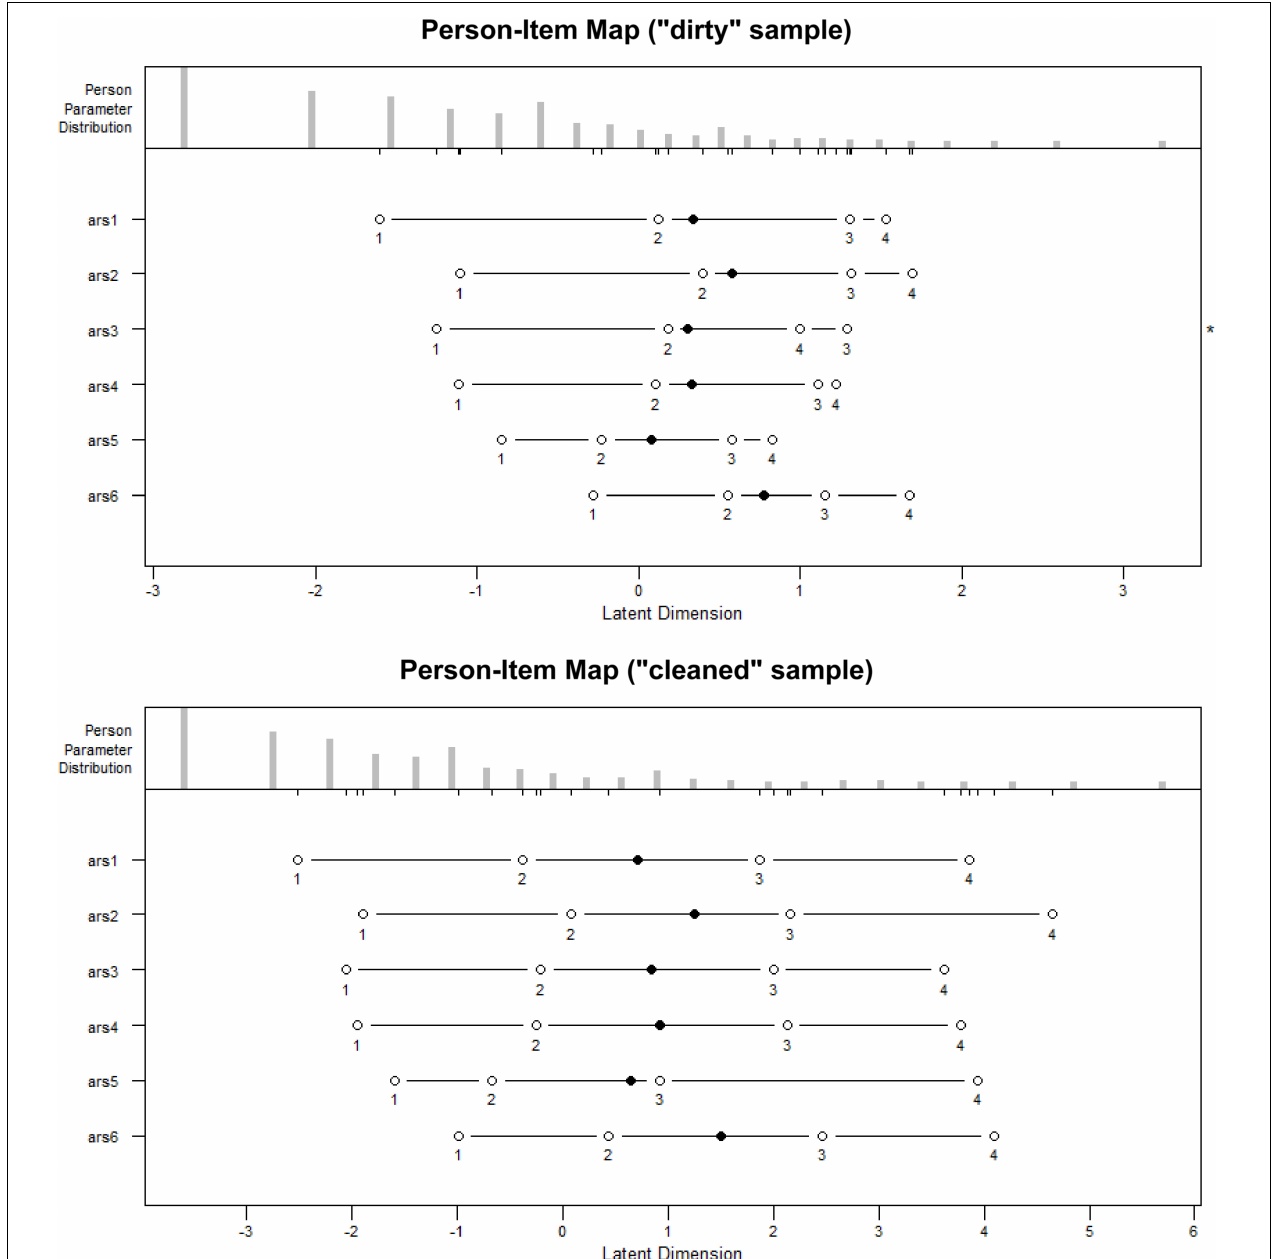
FIGURE 2 | Orderings thresholds: clean and “dirty” sample (SNA-6